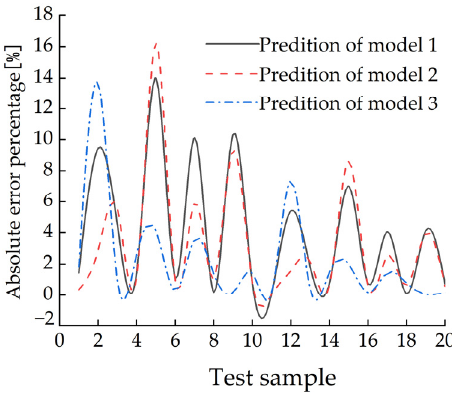
Figure 32. The vertical force prediction results of the three models.